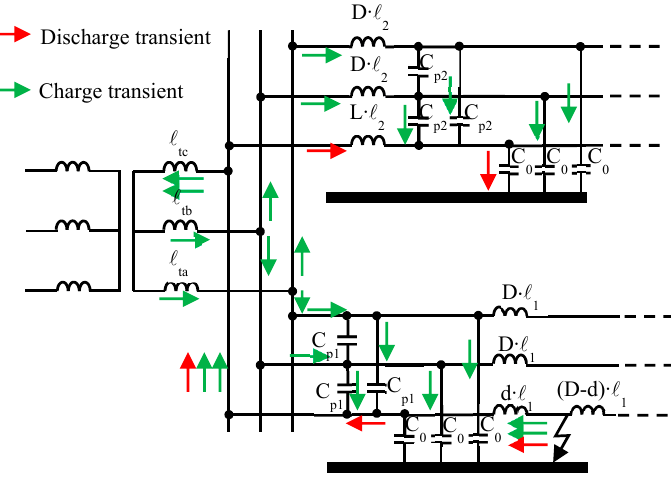
Figure 10. Charge and discharge transient circuits for a double-circuit OHL during a PtG fault